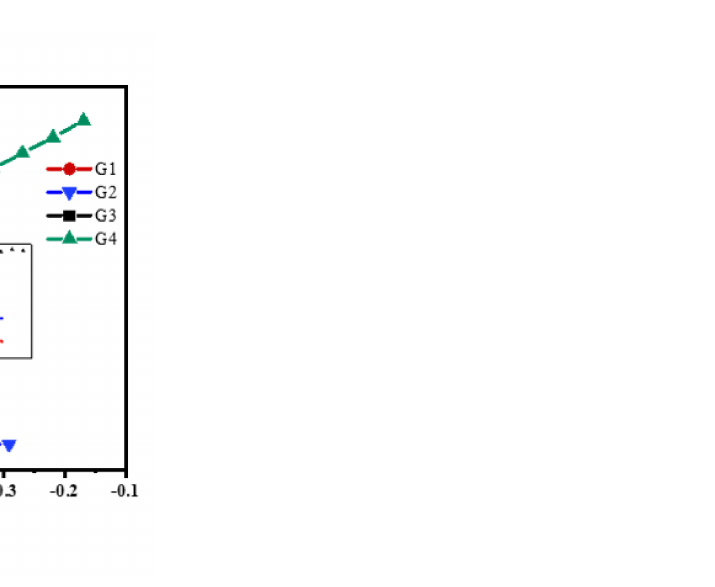
Figure 14. Each coating’s Mott–Schottky pattern for immersion for 45 days: ( a ) 20% Seawater; ( b ) 40% Seawater; ( c ) 60% Seawater.